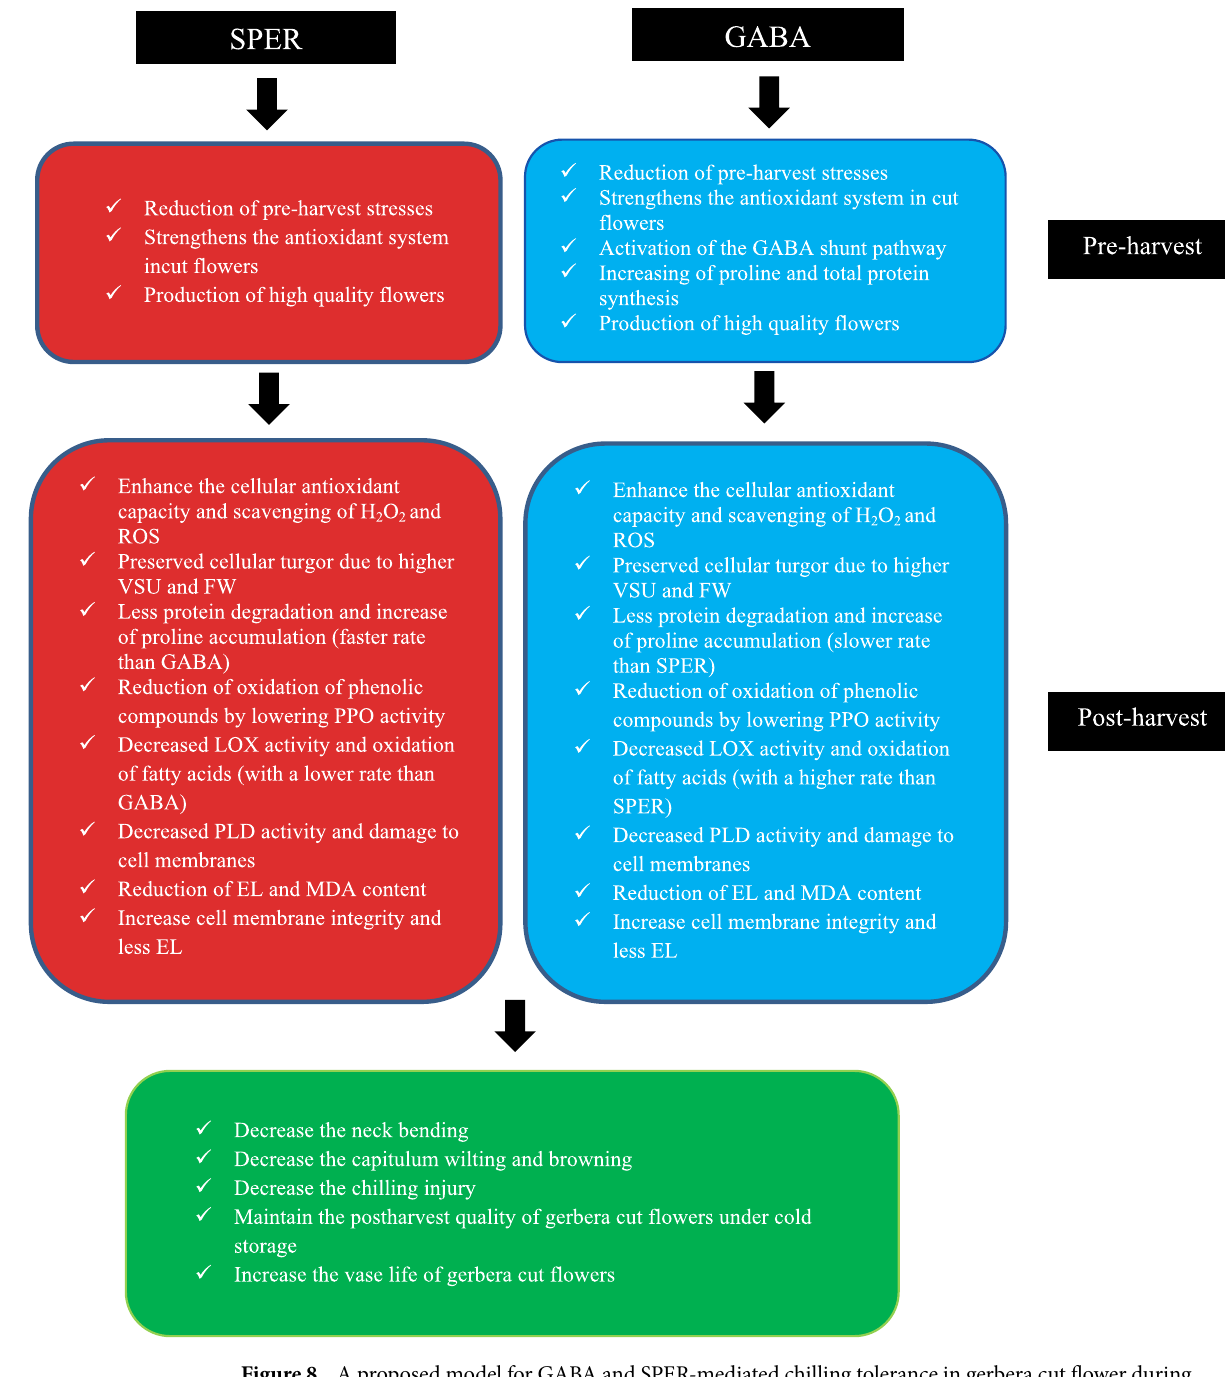
Figure 8. A proposed model for GABA and SPER-mediated chilling tolerance in gerbera cut flower during postharvest cold storage at 1.5 °C and 8 °C. ( ROS reactive oxygen species, VSU vase solution uptake,